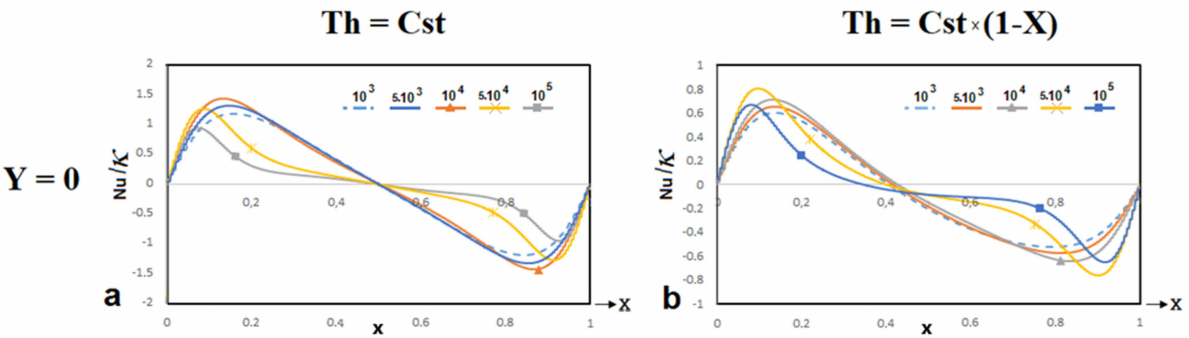
Figure 7. Combined effects of hot temperature distribution and Rayleigh number on Nusselt number evolutions along x -axis: ( a ) Imposed hot temperature Th = Cst and Level Y = 0; ( b ): Imposed hot temperature Th = Cst × (1 − X) and Level Y =